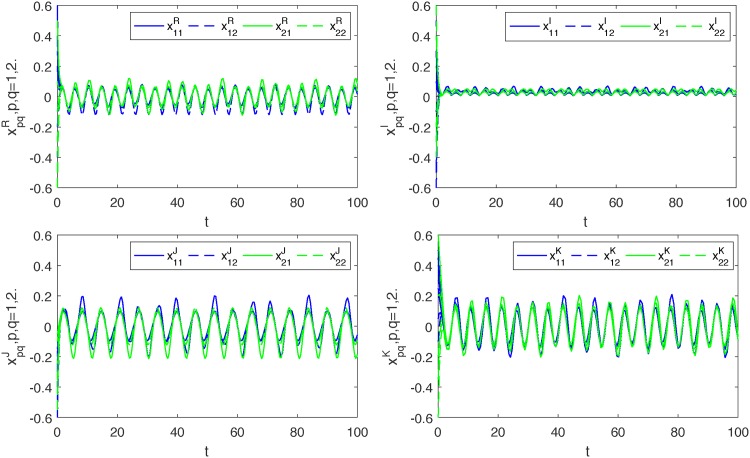
Transient states of four parts of xpq, p, q = 1, 2.